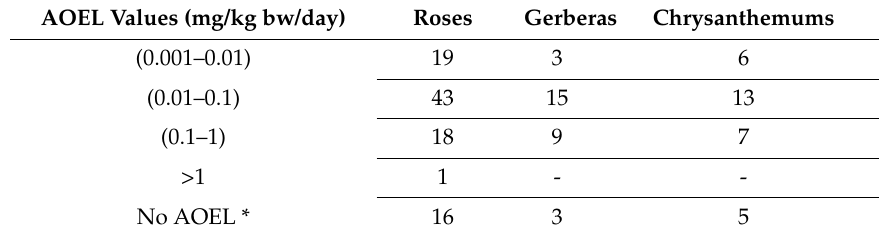
Table 9. Number of active substances detected on the three species of cut flowers classified according to their AOEL values (Source: EU Pesticides Database 2015, European Commission/DGSANCO, Regulation (EC) 1107/2009) [34]. AOEL Values (mg/kg bw/day) Roses